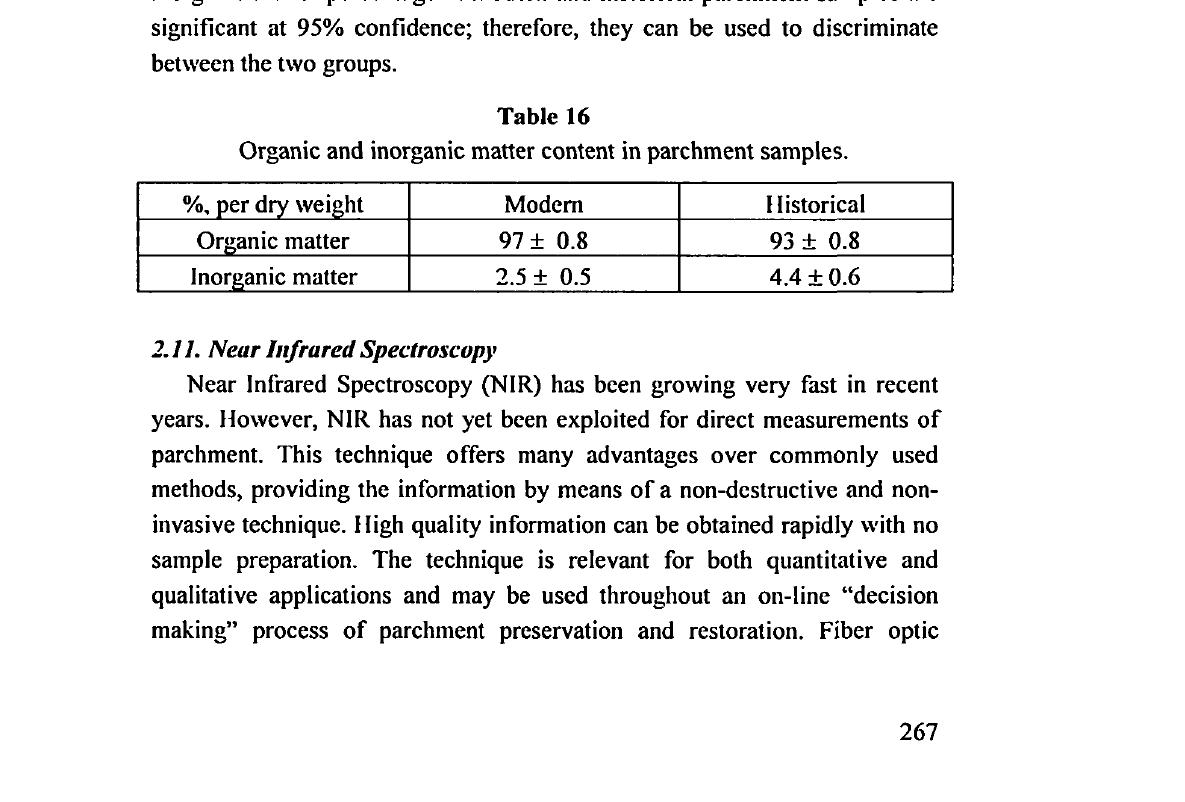
Organic and inorganic matter content in parchment